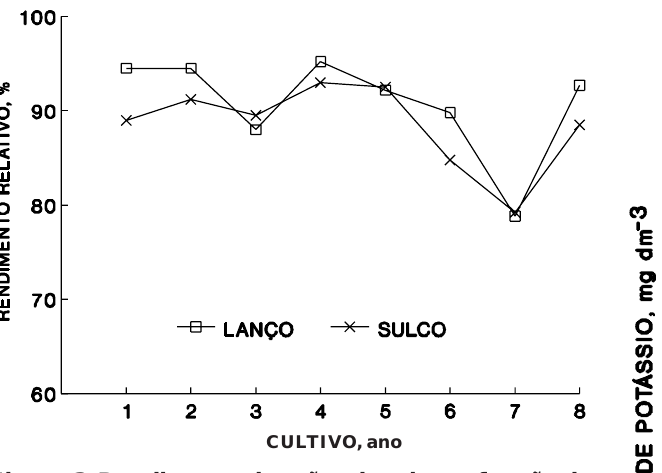
Figura 3. Rendimento de grãos de soja em função da aplicação anual de 40 kg ha -1 de K 2 O no sulco de semeadura ou a lanço. Média de três